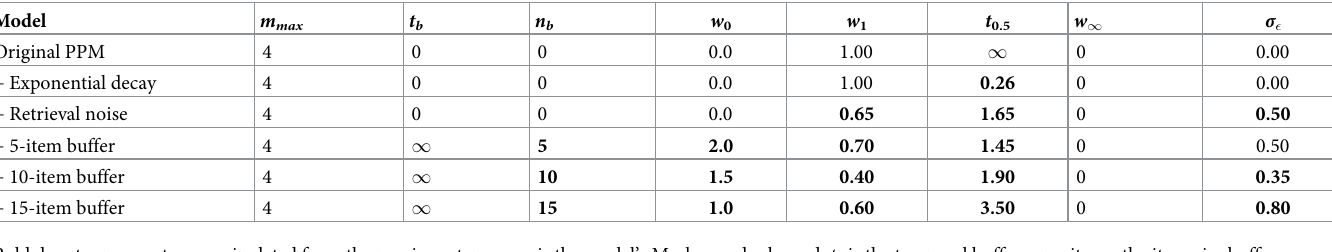
Table 1. Optimized model parameters for Experiment